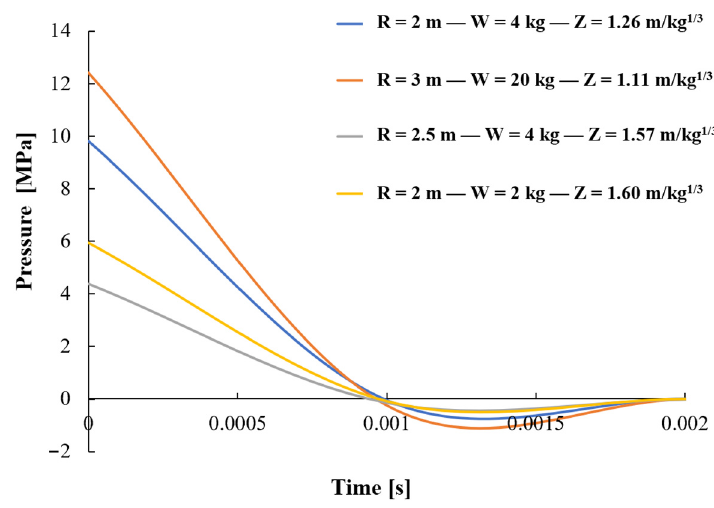
Figure 7. Typical blast pressure–time profile.